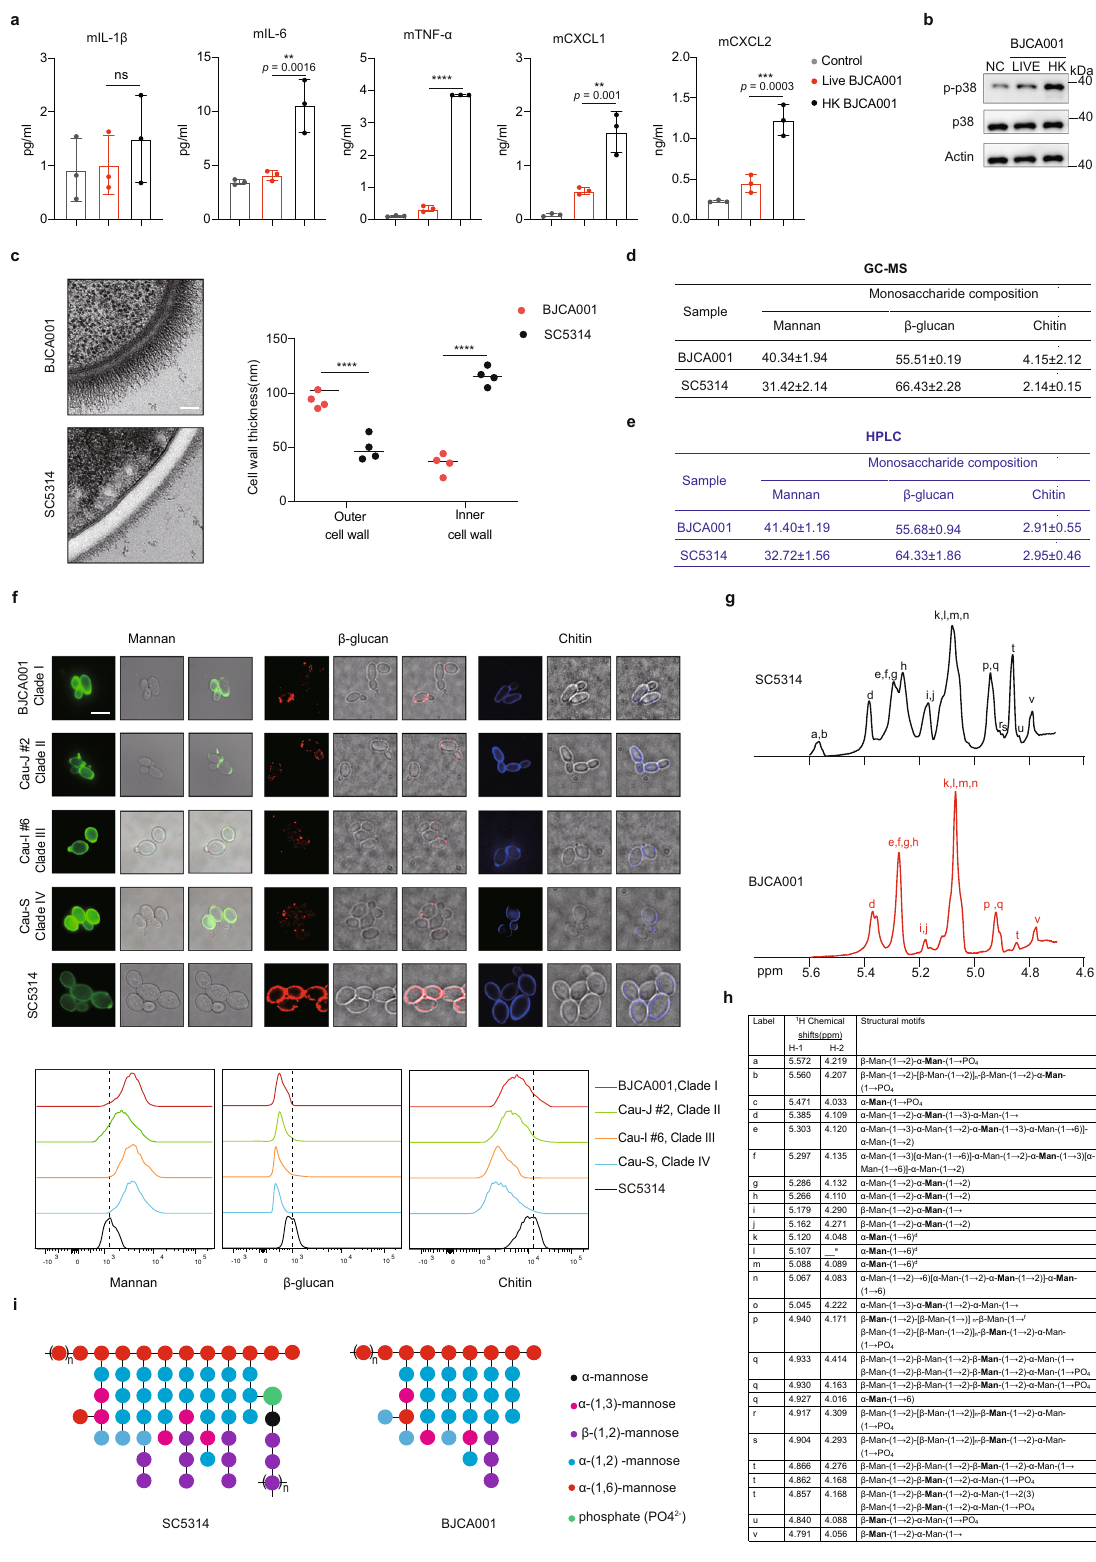
provide indirect evidence supporting the weak recognition and ingestion of C. auris by macrophages. To further validate the essential role of the outer mannan layer of C. auris cell wall in protection against innate immune responses, we focused on various mannan-binding receptors in host, including the mannose receptor (MR), Mincle, DC-SIGN,